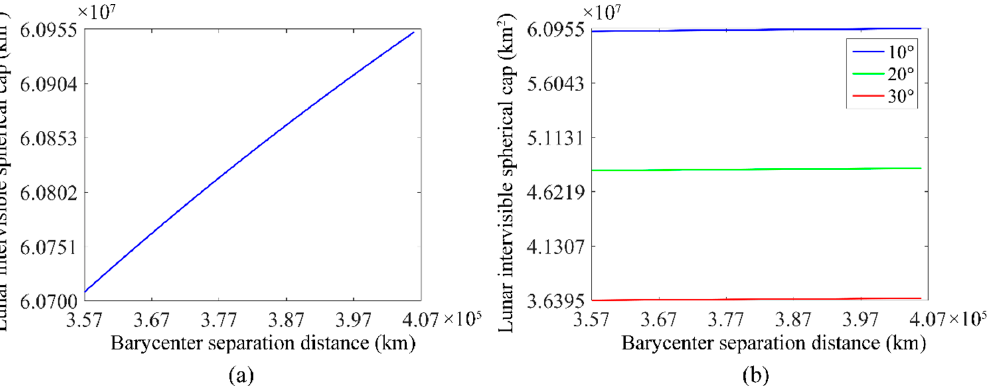
Figure 8. Influences of barycenter separation distance on the lunar intervisible spherical cap ( a ) line-of-sight minimum observation elevation angle is 10°, ( b ) line-of-sight minimum observation elevation angle is 10°, 20°, 30°.